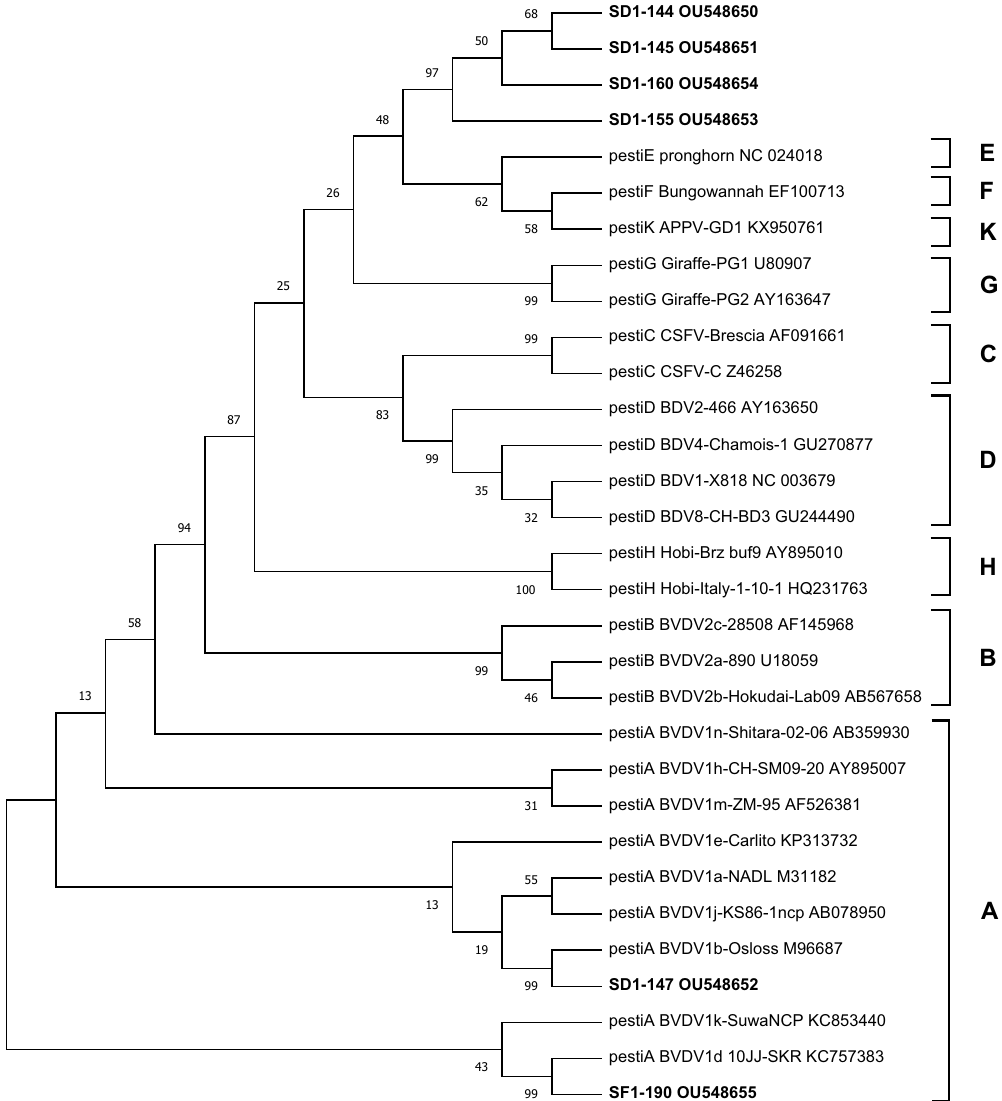
Figure 3. Results of evolutionary analysis of the N Pro coding region from pestivirus sequences obtained from cattle and sheep sampled in the abortion cohort study, northern Tanzania. The evolutionary history was inferred using the Maximum Likelihood method and Tamura-Nei model of nucleotide substitution 35 . The tree with the highest log likelihood is shown. The percentage of trees from 500 Bootstrap repeats in which the associated taxa clustered together is shown next to the branches. Evolutionary analyses were conducted in MEGA X 36 . Reference sequences representing nine pestivirus species were also included 37 and are labelled with virus species ( A – H , K ), genotype and strain name and Genbank accession numbers. Pestivirus species are also shown by bracket labels on the right of the figure. Samples analysed in this study are shown in bold and labelled with unique identifiers (SD/F1-XXX), where SD denotes vaginal swab taken from aborting dam; SF denotes swab taken from aborted foetus. APPV atypical porcine pestivirus, BDV border disease virus, BVDV bovine viral diarrhoea virus, CSFV classical swine fever